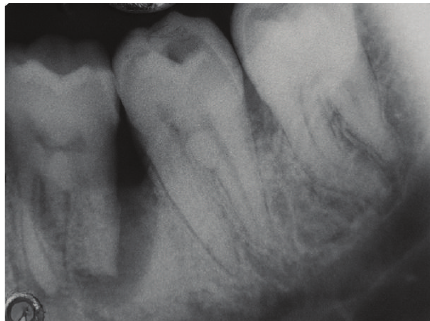
Figure 3: 1-month follow-up.